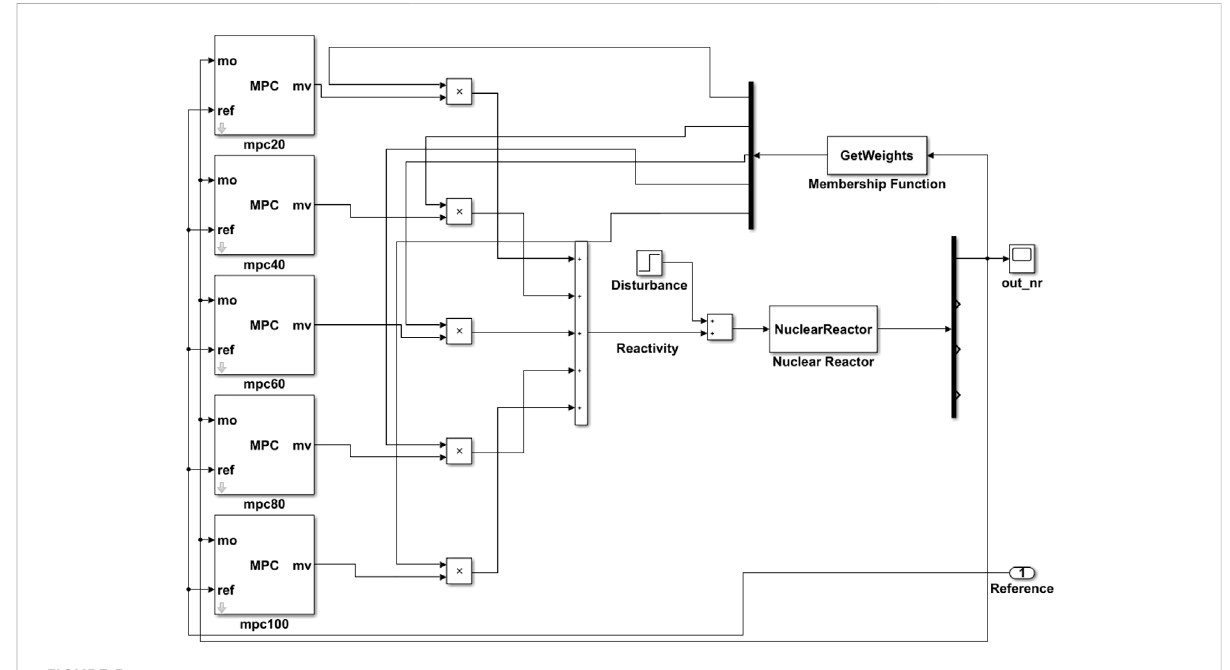
Schematic diagram of the designed FMPC controller by